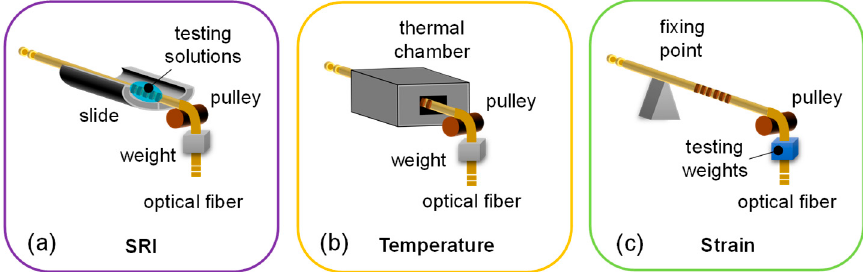
Figure 7. Schematic setup for the characterization of LPG towards: ( a ) surrounding refractive index; ( b ) temperature; and ( c ) strain.